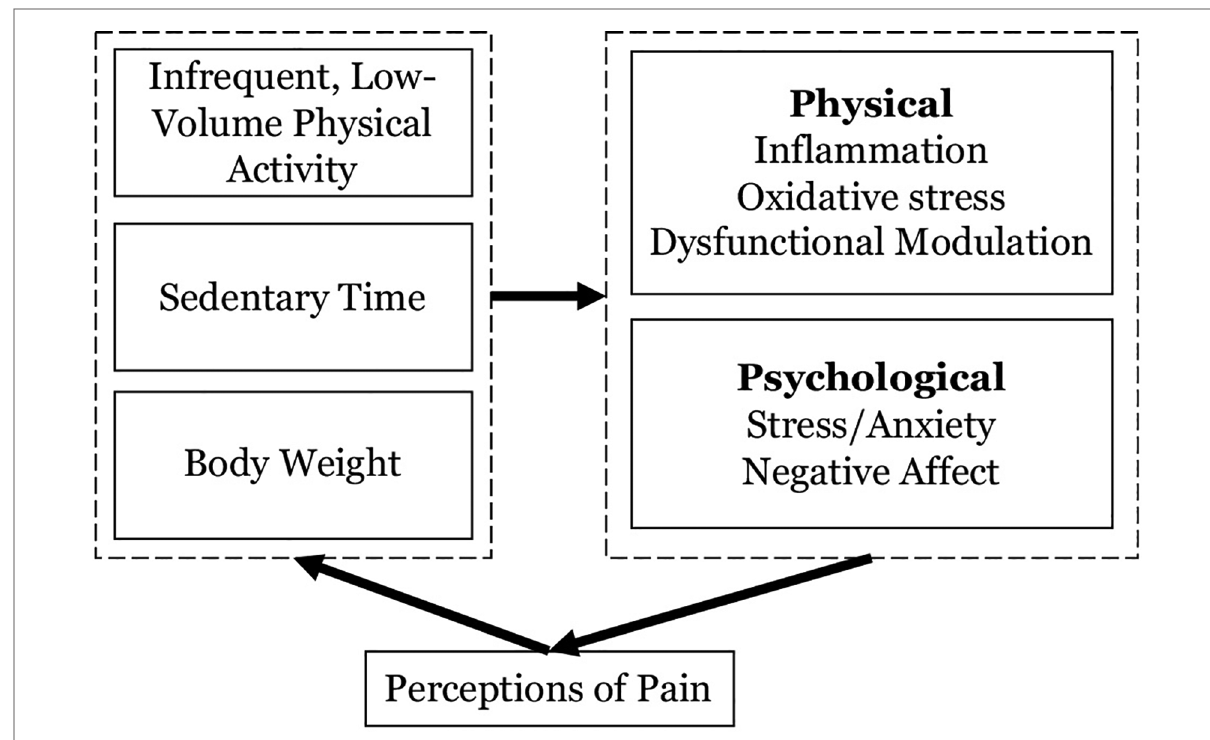
FIGURE 1 The cycle of movement dysregulation, excess body weight, and perceptions of